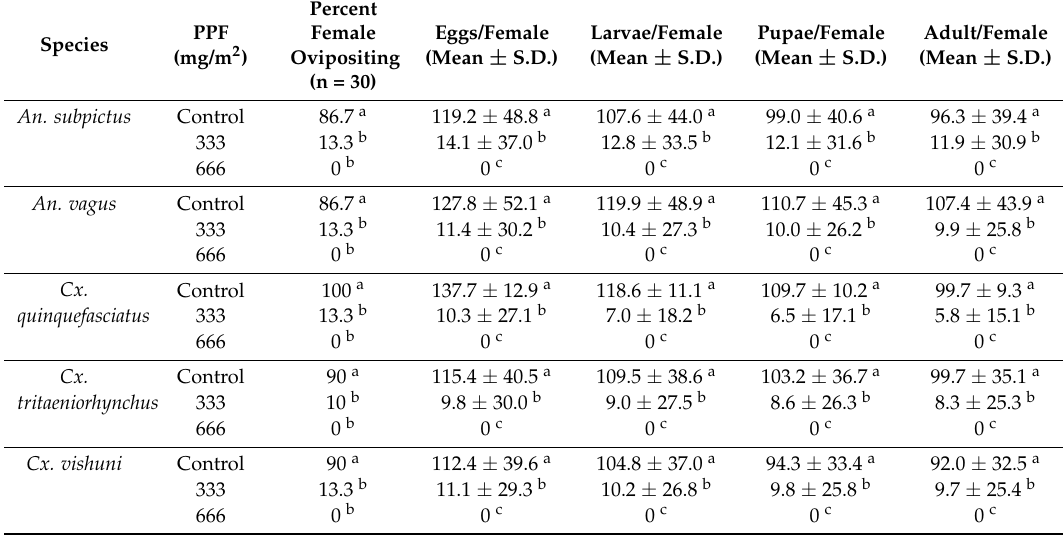
Table 1. Reproductivity of engorged females after 30 min of exposure to PPF (pyriproxyfen)-treated polypropylene sheets in the cone